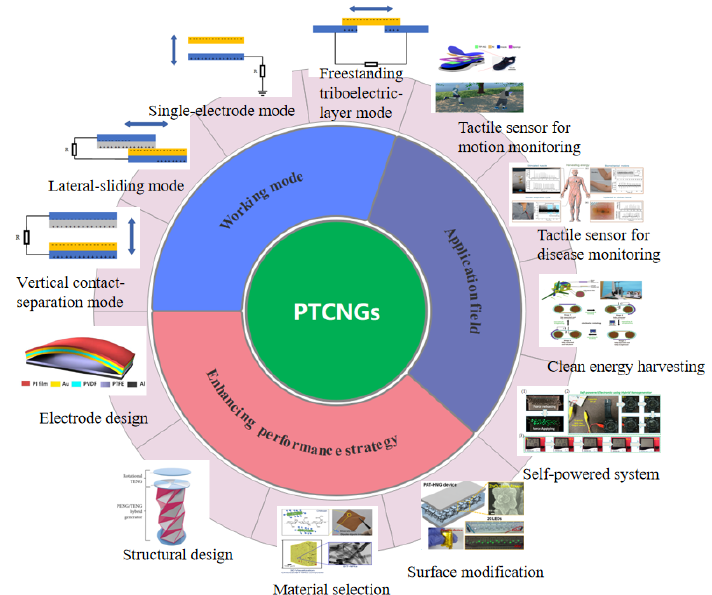
Figure 1. Recent progress of